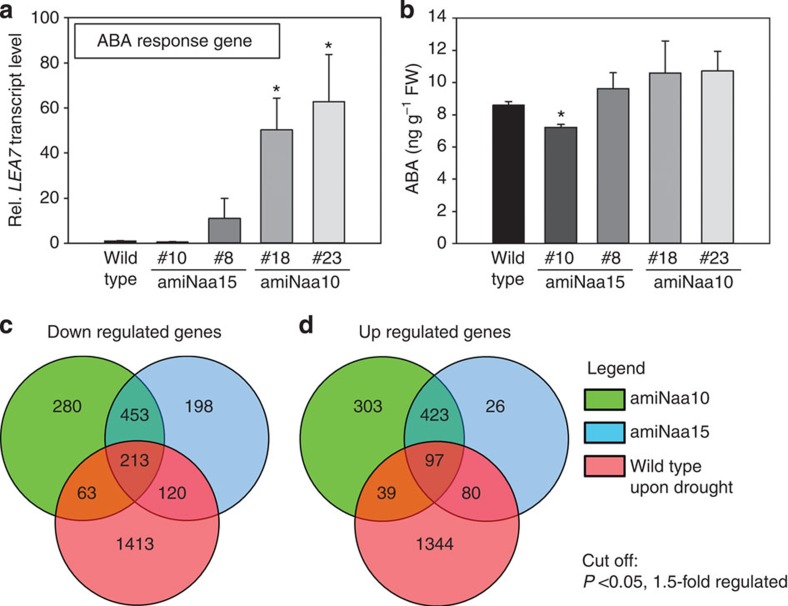
Transcriptional response to NatA depletion.ABA steady-state levels and transcription of ABA-related genes were determined in leaves of 6-week-old wild type and NatA depleted grown on soil with regular water supply. (a) Transcript steady-state level of the ABA-inducible marker gene, LEA7. (N=3) (b) Steady-state levels of ABA. (N=5) (a,b) Data are represented as mean±s.e. Asterisks indicate significant differences to wild type. (P<0.05, Student's t-test). (c,d) Venn diagrams for comparison of downregulated (c) and upregulated genes (d) in wild-type plants by drought stress (10 days) with genes that are regulated in NatA-depleted plants under control conditions when compared with wild type. Global transcriptional response in leaves of well-watered amiNaa10 (green), amiNaa15 (blue) was compared with non-stressed wild-type plants (control) as determined by hybridization of total mRNA to the Gene 1.0 ST Array (Affymetrix, Germany). (N=4).